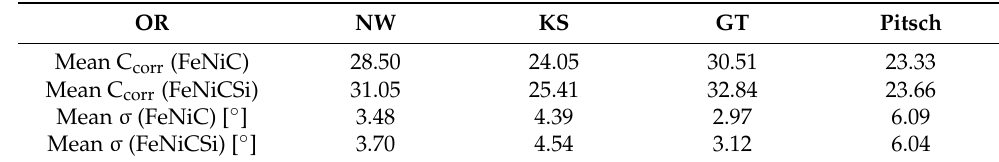
Table 4. Mean correlation coefficients C corr and mean orientation angle deviation σ calculated for FeNiC and